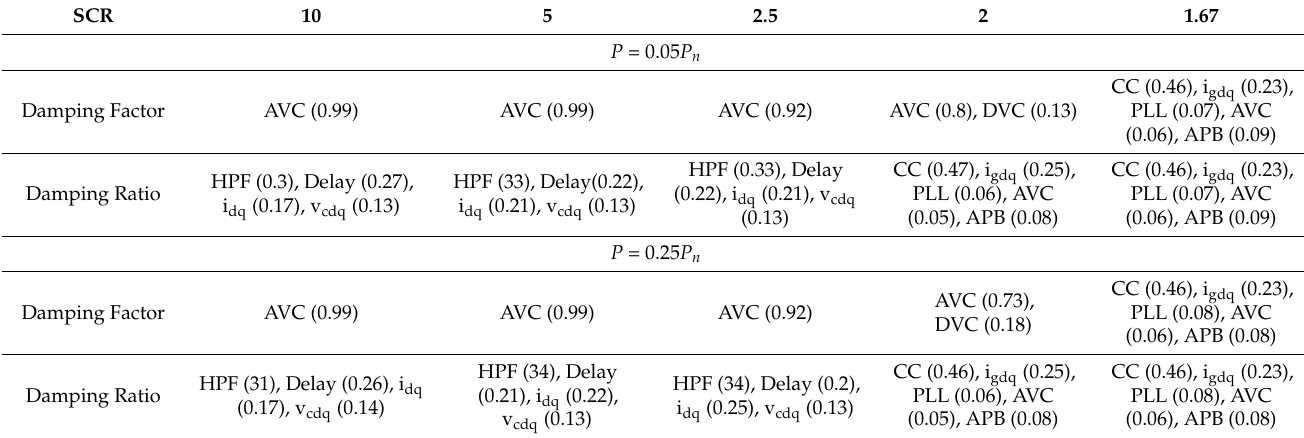
Table 3. Participation factor analysis of critical modes for different grid SCRs and power